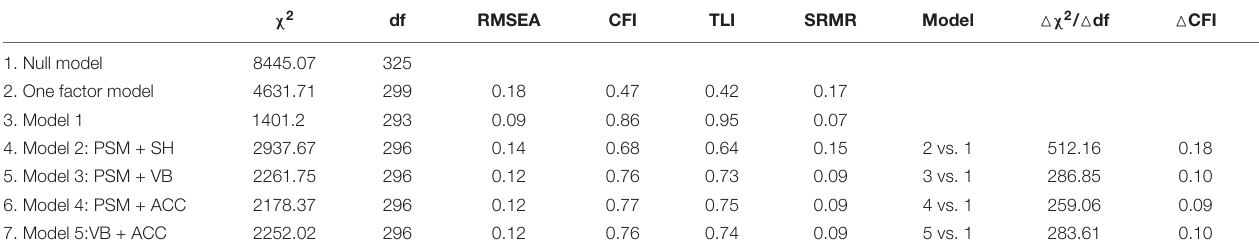
TABLE 1 | The confirmatory factor analysis results.